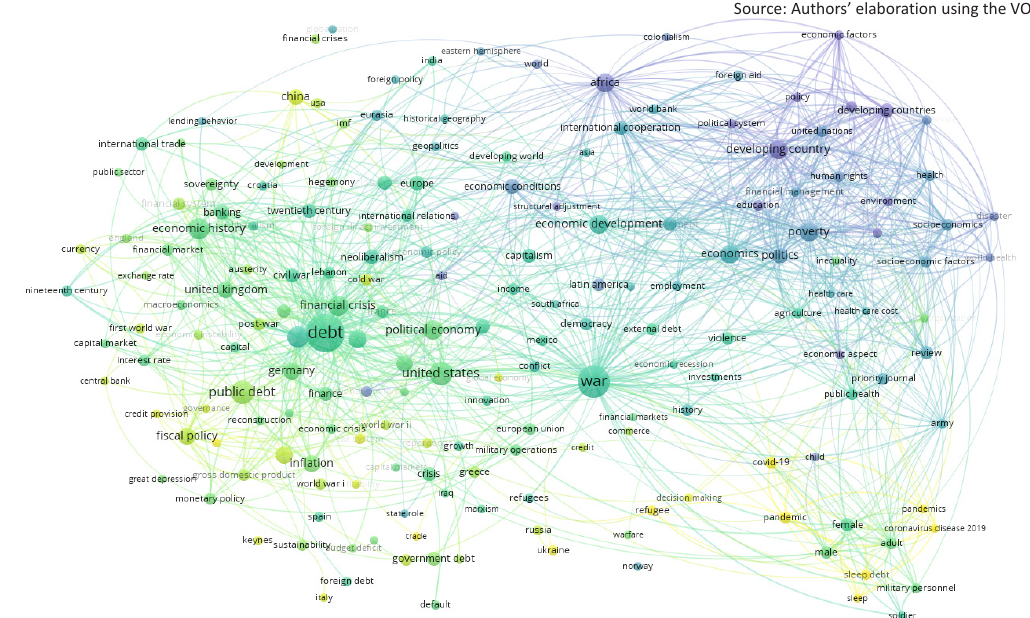
Figure 6. Visualization map of the contextual-temporal dimension of research on public debt in 2000–2022 in